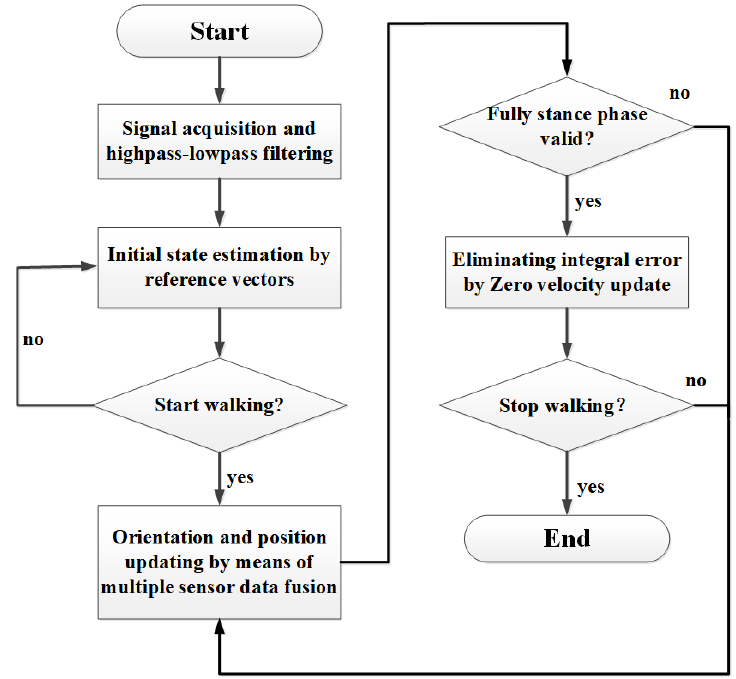
Figure 6. Flowchart of the proposed